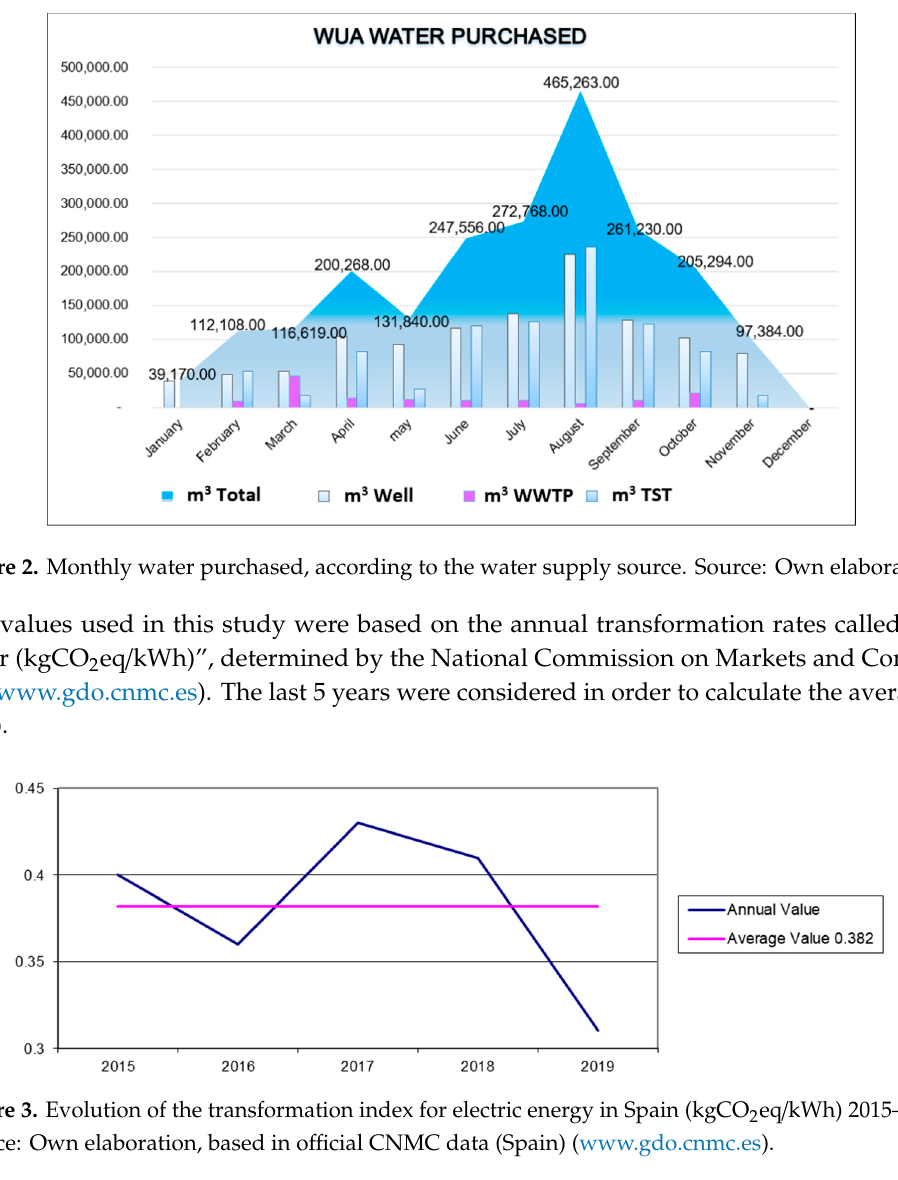
Figure 3. Evolution of the transformation index for electric energy in Spain (kgCO 2 eq/kWh) 2015– 2019. Source: Own elaboration, based in official CNMC data (Spain) (www.gdo.cnmc.es).